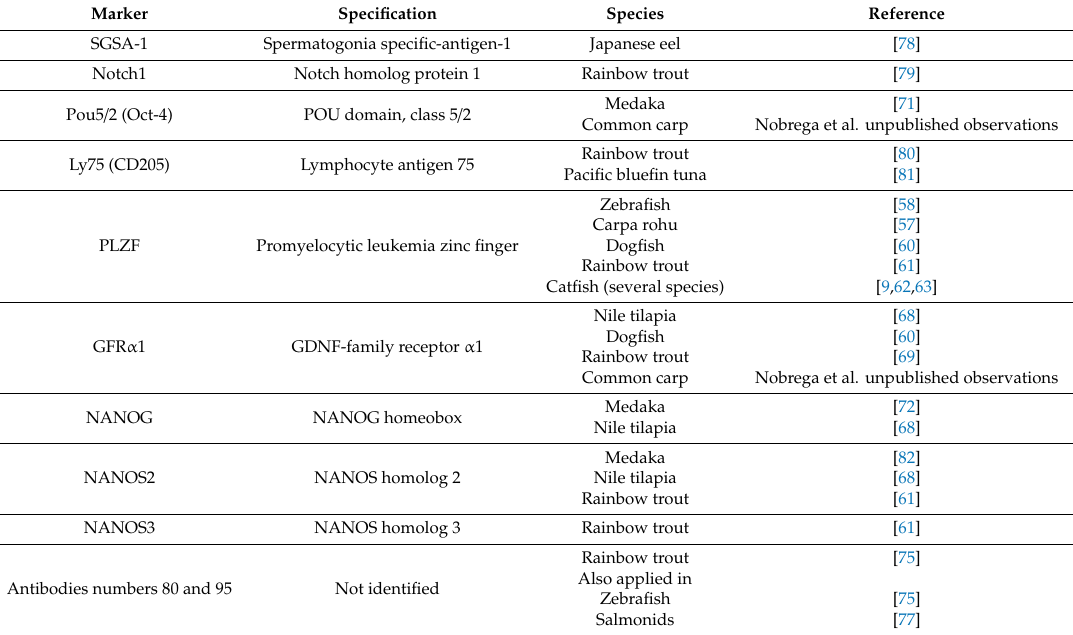
Table 1. Spermatogonial stem cell markers in